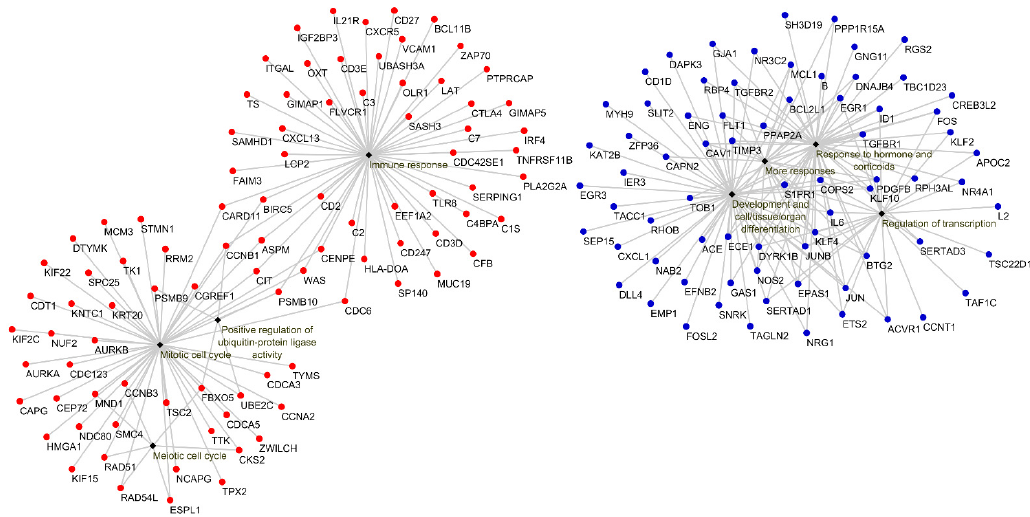
Figure 5. Enriched functional GO terms groups obtained with FatiGO (Babelomics 4.3) in the significant up-regulated (red) and down-regulated (blue) genes when comparing the Lesions group with the Seronegative group. p value is the highest adjusted p value of its groups GO terms: Mitotic cell cycle ( p = 3.91 × 10 − 19 ), Meiotic cell cycle ( p = 1.77 × 10 − 3 ), Immune response ( p = 4.14 × 10 − 11 ), Positive regulation of ubiquitin-protein ligase activity ( p = 9.14 × 10 − 3 ), Development and cell/tissue/organ differentiation ( p = 1.11 × 10 − 10 ), Regulation of transcription ( p = 7.97 × 10 − 5 ), Response to hormone and corticoids ( p = 1.35 × 10 − 7 ), More responses ( p = 1.16 × 10 − 6 ).